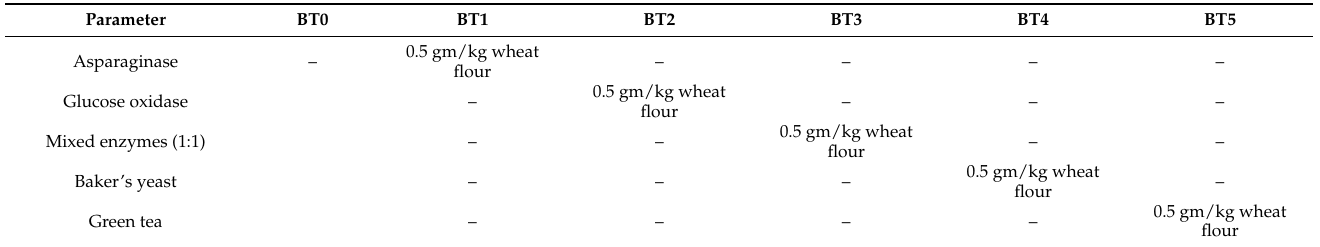
Table 1. Treatment descriptions and the percentage of different treatments for biscuit manufacturing.